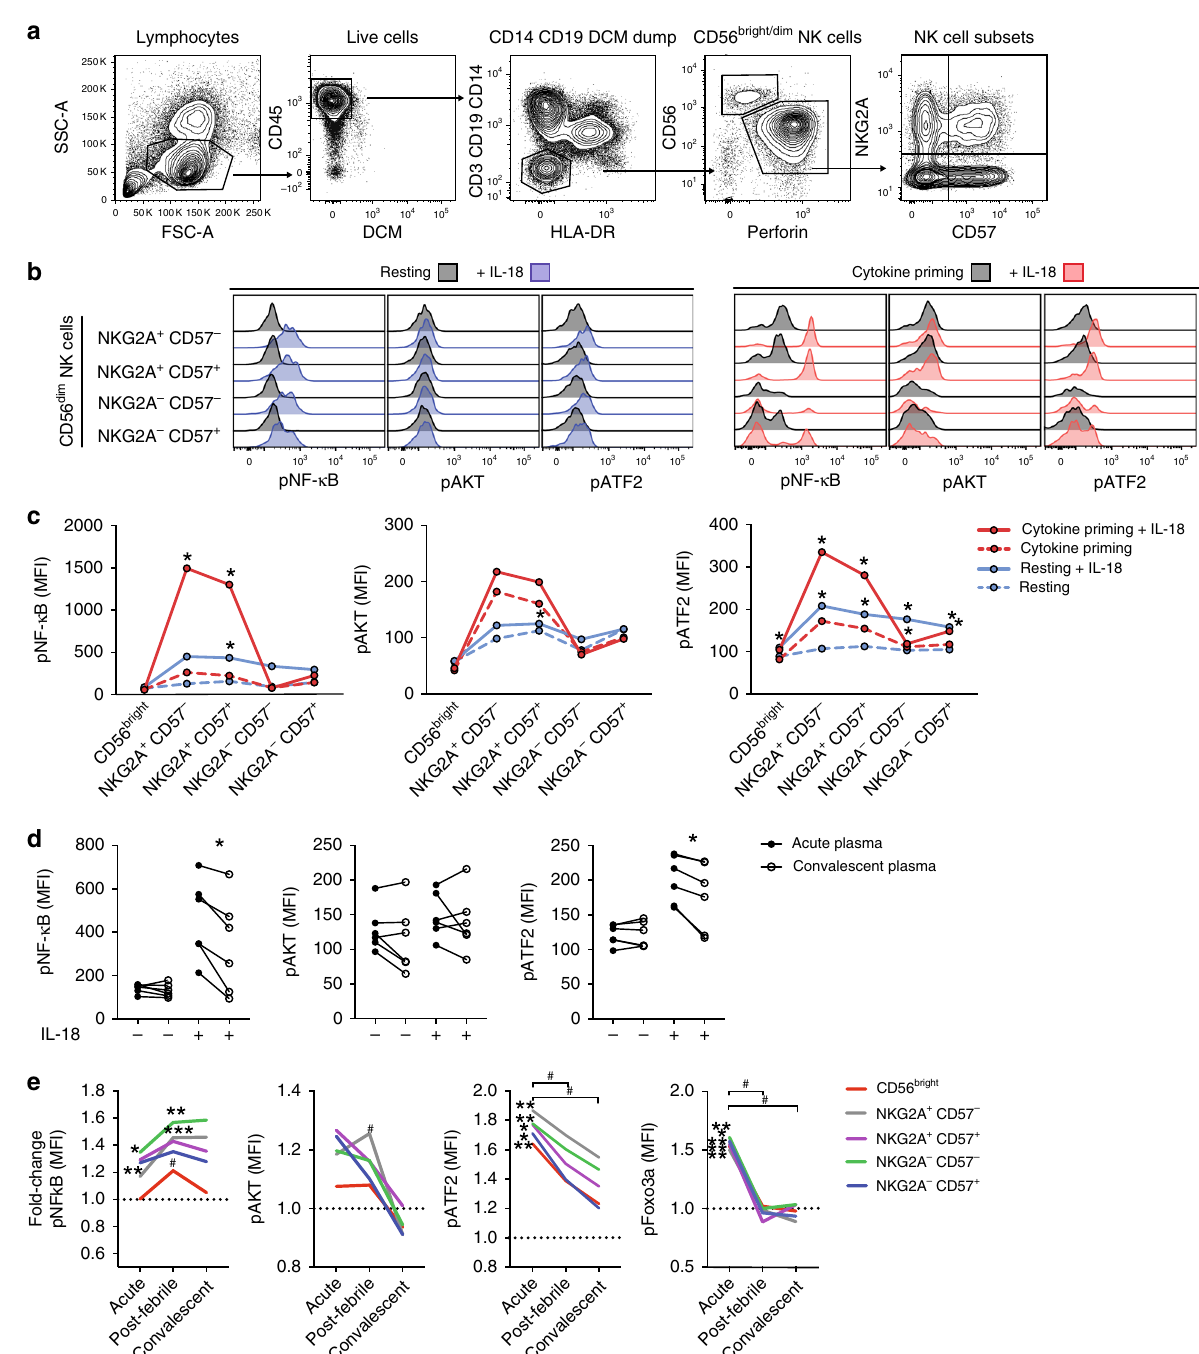
Fig. 5 Changes in signaling downstream of the interleukin-18R (IL-18R) during acute dengue virus (DENV) infection. a Gating strategy to identify CD56 bright and CD56 dim natural killer (NK) cell subsets from total peripheral blood mononuclear cells (PBMCs) after methanol fi xation. b Representative histograms showing staining for pNF- κ B, pAKT, and pATF2 in CD56 bright and CD56 dim NK cell subsets from healthy controls, rested (blue) or cytokine primed, with (blue or red) or without (gray) the addition of IL-18. c Results summarized from experiments in b ( n = 6). d Phospho fl ow epitope staining of NKG2A + CD57 − CD56 dim NK cells from healthy controls that were pre-incubated with patient sera, from the acute or convalescent phase, with or without IL-18 stimulation. e Ex vivo expression of pNF- κ B, pAKT, pATF2, and pFOXO3A in CD56 bright and CD56 dim NK cell subsets from the acute, post-febrile, and convalescent phase of DENV infection ( n = 6). Statistical differences were tested using paired t test or Wilcoxon ’ s matched-pairs signed-rank test. Stars (*) indicate signi fi cant differences between the non-IL-18 control compared to the IL-18-stimulated condition ( c ) or signi fi cant differences between patients and healthy controls ( e ); hashes (#) indicate signi fi cant differences between the acute phase and follow-up time points of patients with DENV infection ( e ). # P < 0.05; * p < 0.05, ** p < 0.01, and *** p < 0.001. Source data are provided as a Source Data fi